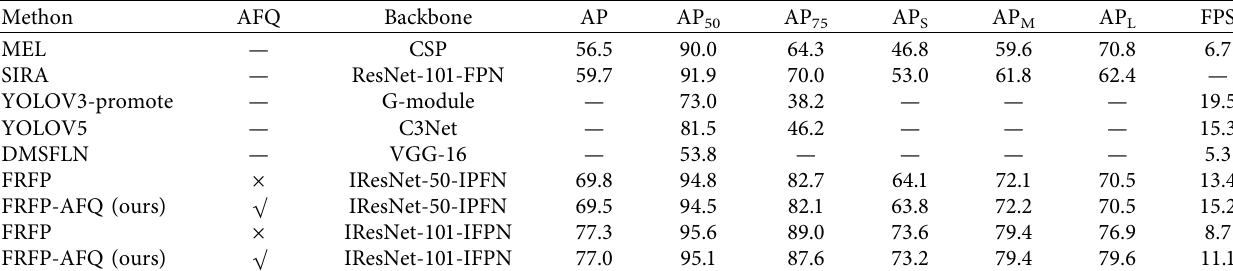
Table 3: Comparison results with conventional pedestrian detection